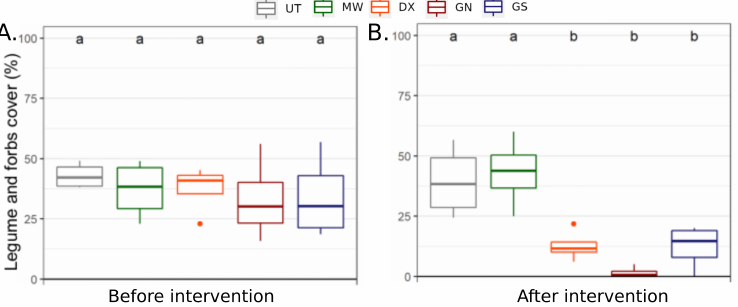
Figure 3. Results of experiment 1: botanical composition before ( A ) and after ( B ) four weeks of mowing or herbicide spraying: untreated (UT), mowing (MW), Doxstar ® (DX), Genoxone ® (GN) and Garlon Super ® (GS). Letters indicate results of Tukey test (after intervention p < 0.001). Outliers are represented with a dot.